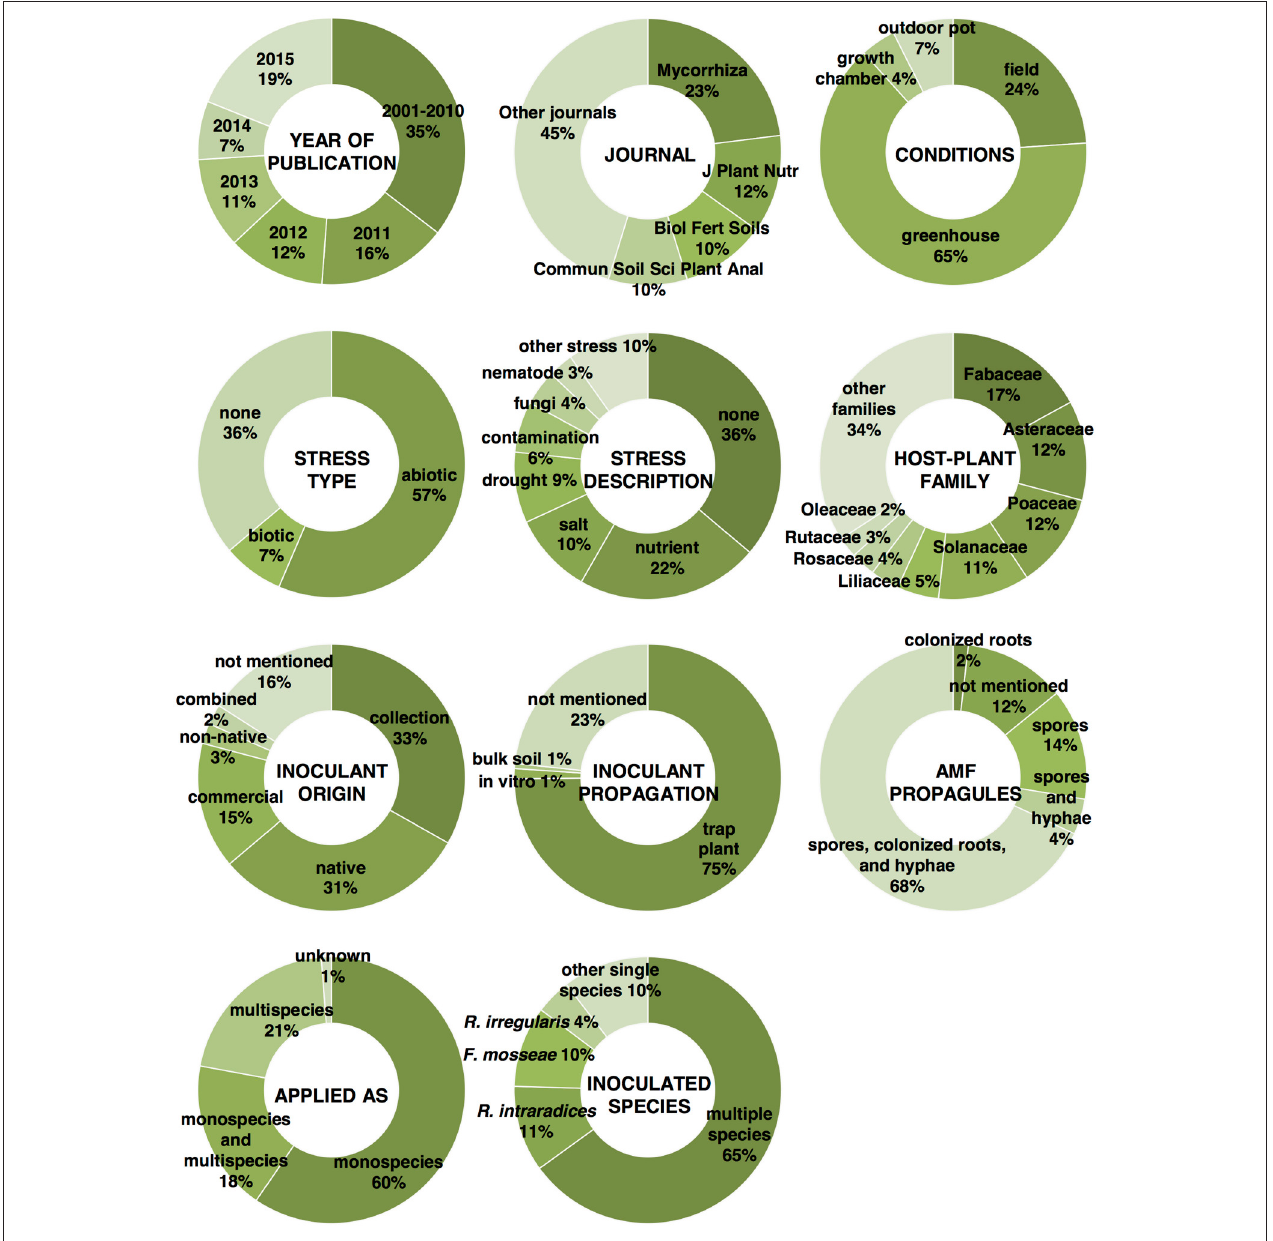
FIGURE 1 | Percentage of reviewed articles according to the year of publication and to the scientific journal, and percentage of experiments illustrated in the reviewed articles according to the cultivation conditions, stress type, and description, mycorrhizal host-plant family, origin of the AMF inoculants, method of AMF propagation used prior to inoculation, type of AMF propagule, method of application, and inoculated AMF